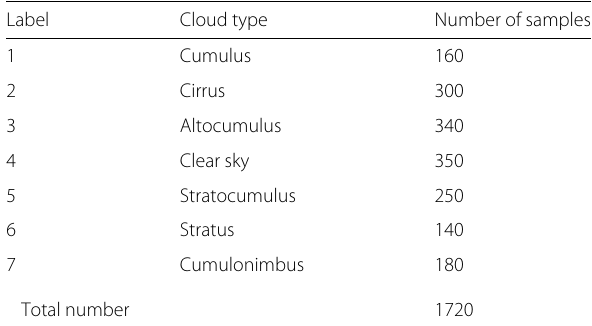
where V is the visual feature vector, i.e., activations-based or FC-based feature vector, and M = denotes the multimodal feature vector. For simplicity and